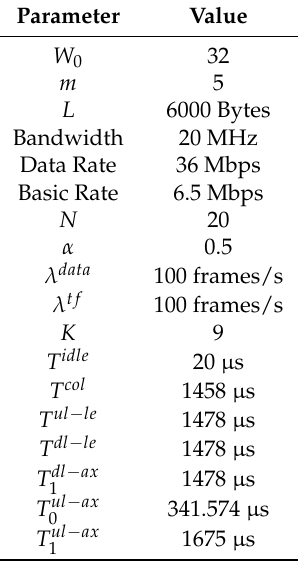
Table 1. Default Simulation